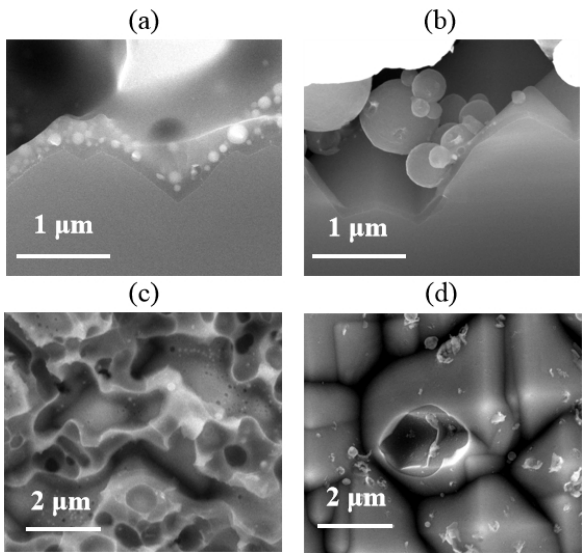
Figure 7. ( a , b ) Cross section scanning electron microscope (SEM) images of Cell 1 and Cell 2, obtained at the Si/metallization interface; ( c , d ) SEM images of Si substrate surface etched area after the paste removal.